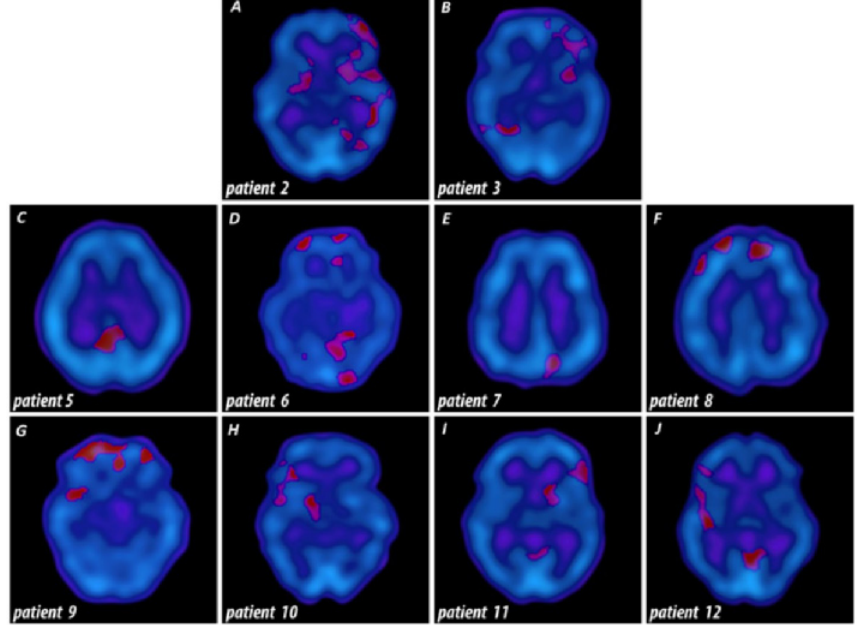
Figure 2. Perfusion decrease after activation (red color) in voxel-based analysis in patients 2-3 (A-B) and 5-12 (C-J).